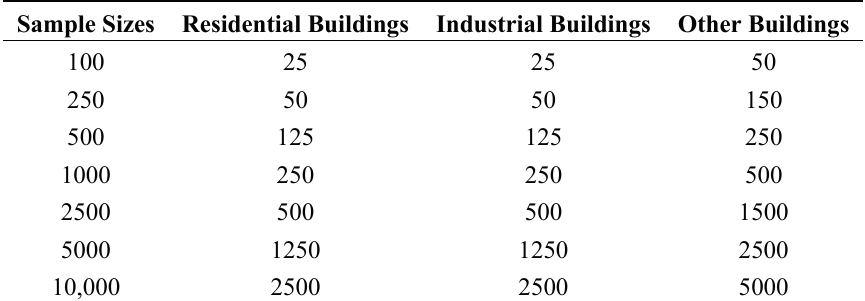
Table 1. Distribution of class objects within each sample